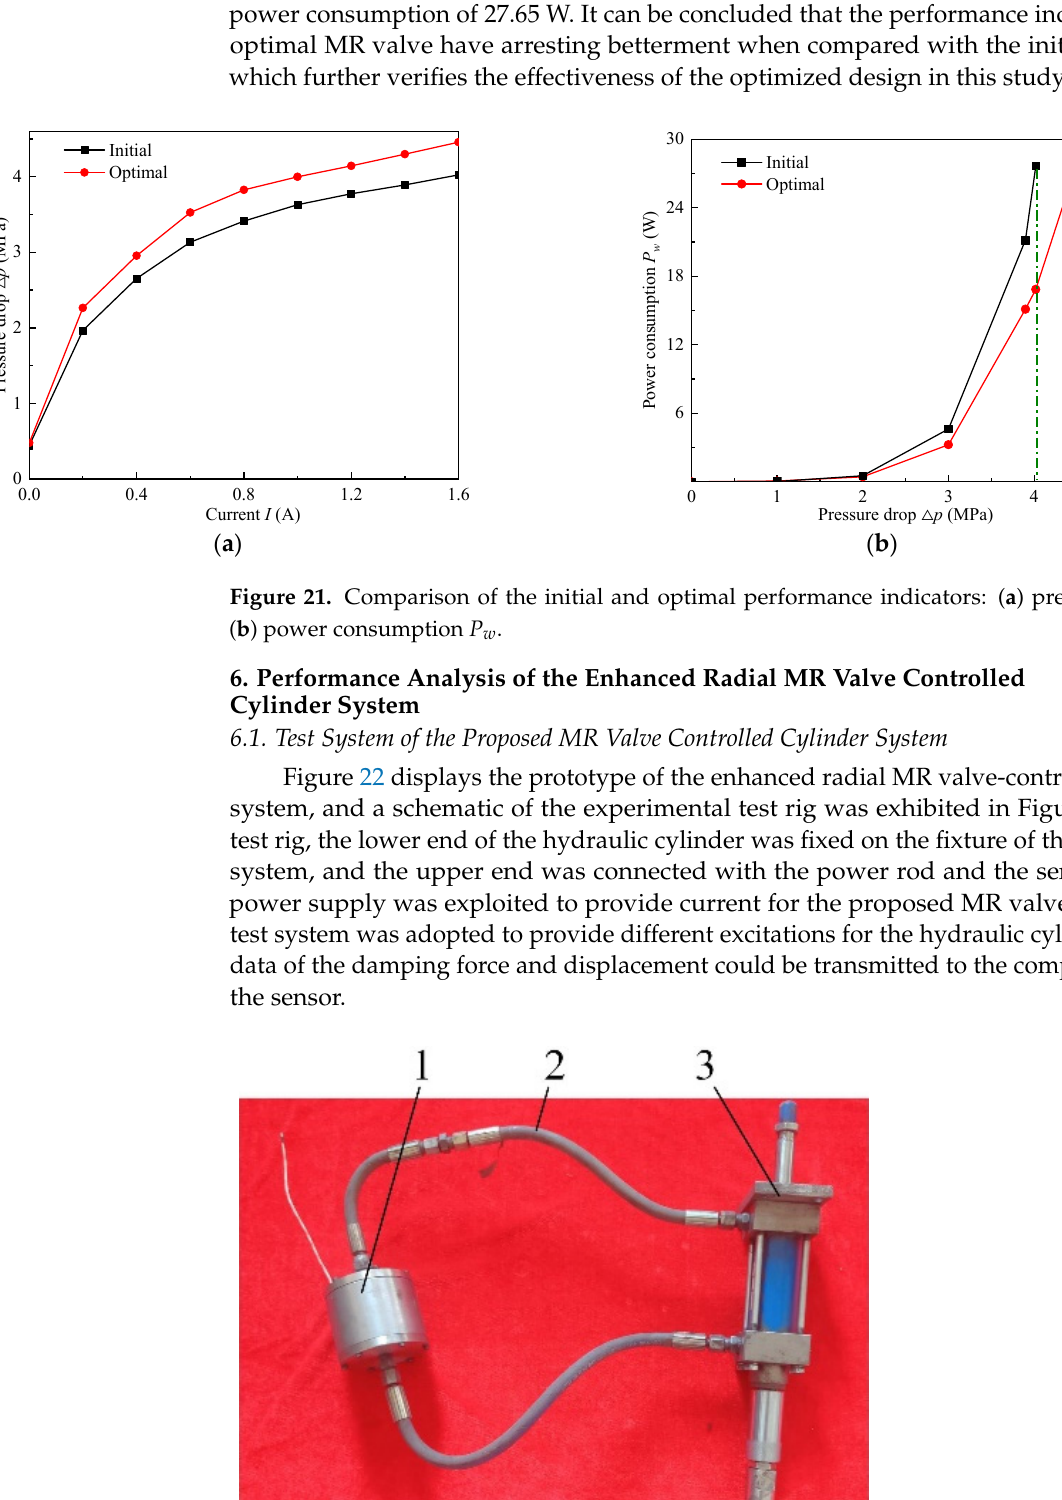
Figure 22. Prototype of the proposed MR valve-controlled cylinder system: 1. Enhanced radial MR valve, 2. Hydraulic pipe, 3. Double rod hydraulic cylinder.